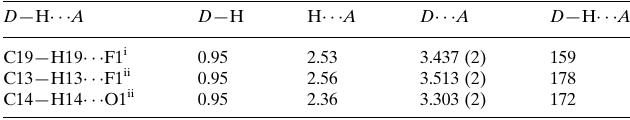
Hydrogen-bond geometry (A˚ , (cid:2)